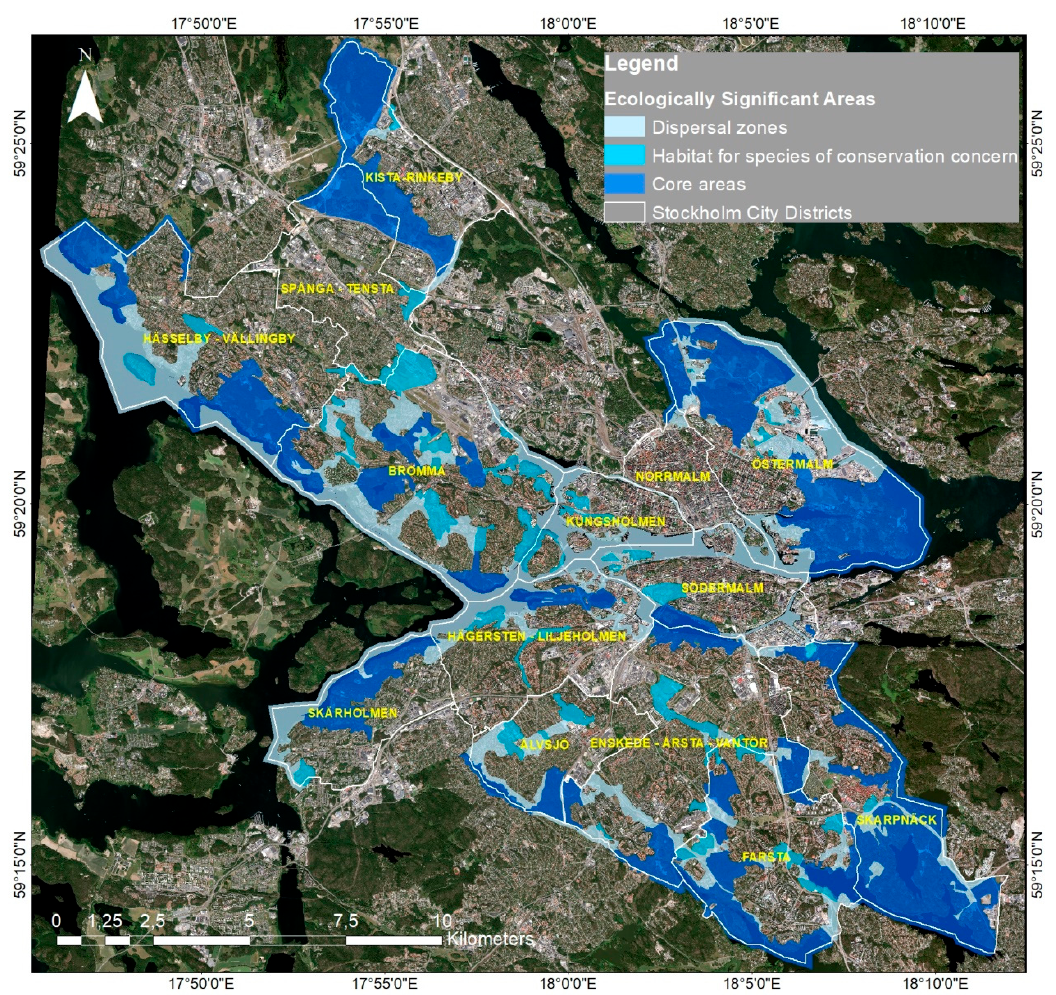
Figure 1. The Stockholm City study area. District boundaries are outlined in white and labeled in yellow. The three types of ecologically significant areas of the city’s green infrastructure are shown in different shades of blue with WorldView-2 imagery from July 4, 2018 as a backdrop.